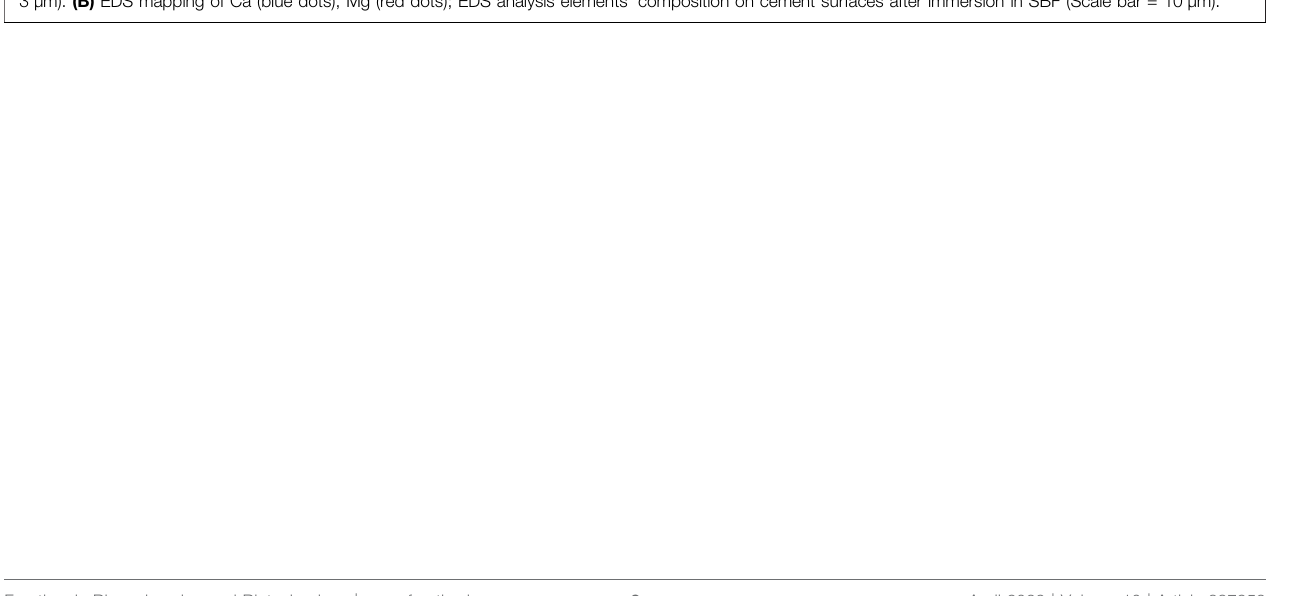
Frontiers in Bioengineering and Biotechnology |